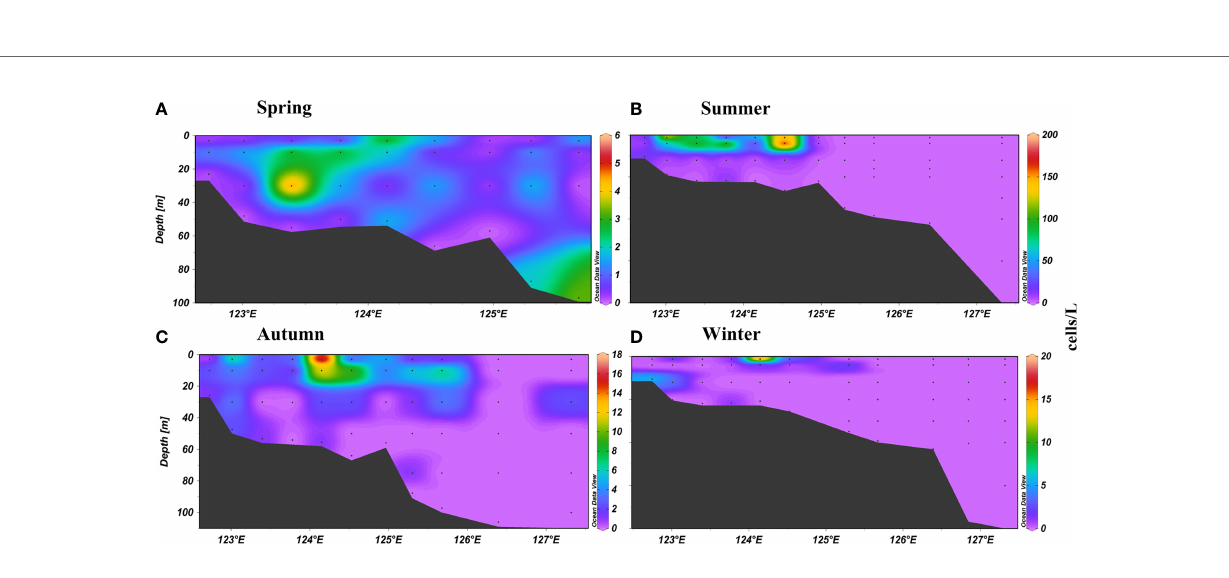
FIGURE 5 | Vertical distribution of N. scintillans abundance (cells/L) along section P. (A) spring; (B) summer; (C) autumn; (D) winter.